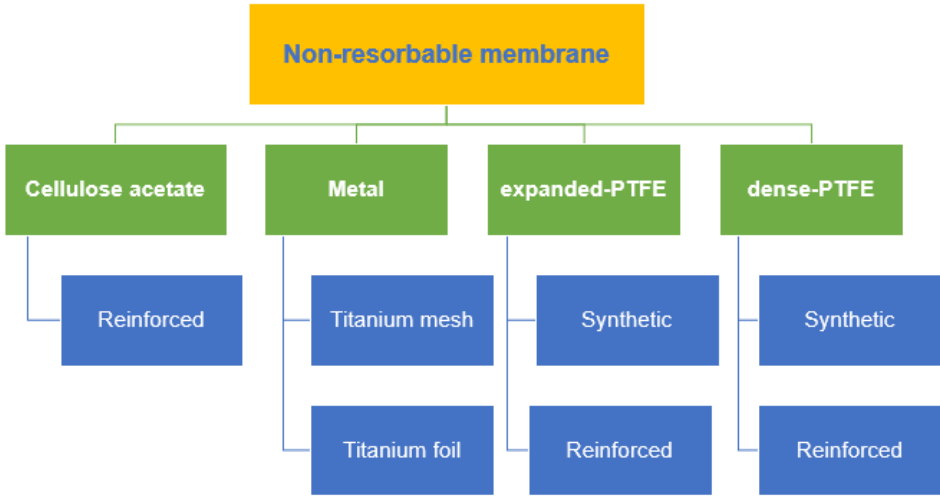
Figure 1. Various types of non-resorbable membranes .